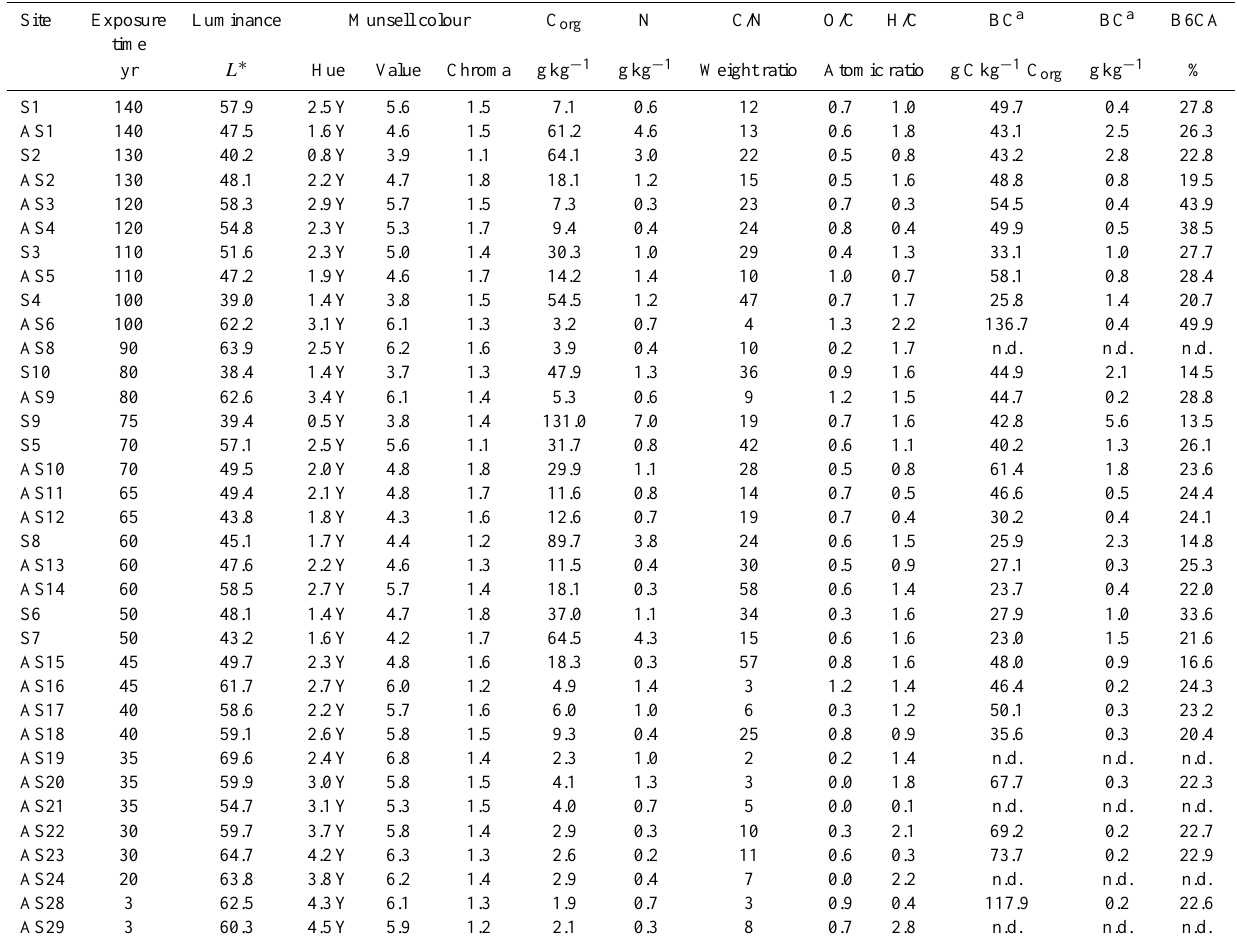
Table 2. Spectral and chemical properties of the fine-earth fraction ( <